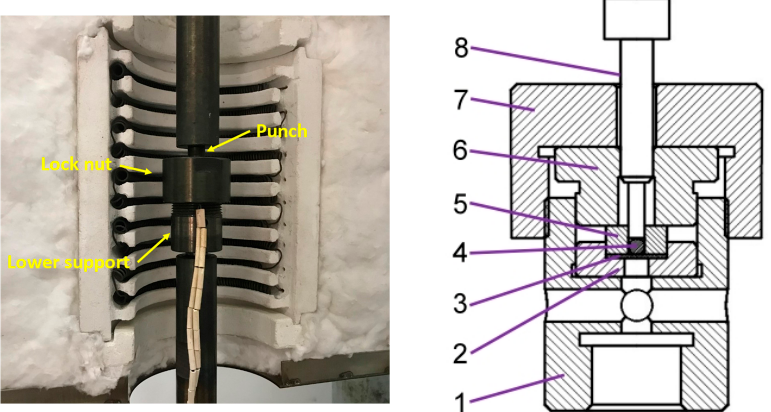
Figure 5. Schematic diagram of small punch test. 1. Lower support 2. Lower die 3. Specimen 4. Ball 5. Guide block 6. Upper die 7. Lock nut 8. Punch.